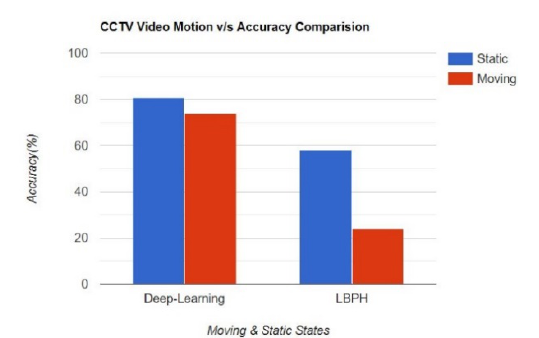
Figure 10 . Static and Moving Objects accuracy in Mobile Video